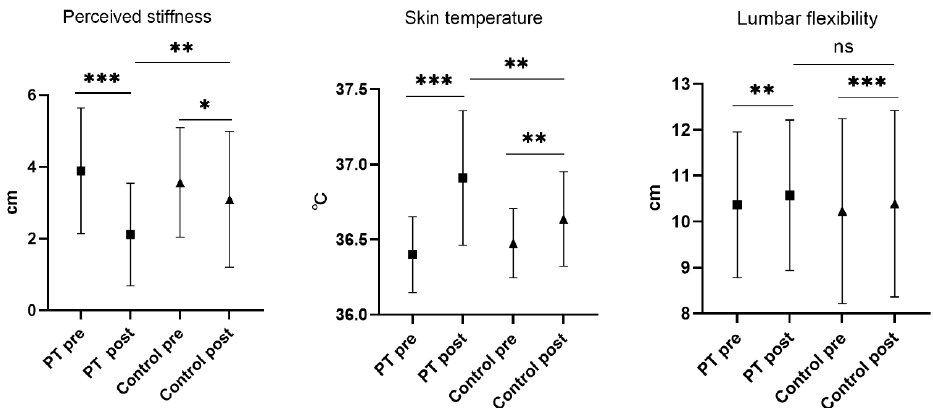
Figure 5. Results of inter-group and intra-group comparisons of other outcomes. Abbreviations: PT: percussive massage therapy; Control: control group; Pre: before the intervention; Post: after the intervention. * represents p < 0.05, ** represents p < 0.01, *** represents p < 0.001, ns represents no significant differences.